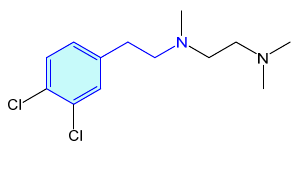
Figure 22 . A 2-Phenethylamine Sigma-1 receptor hit.